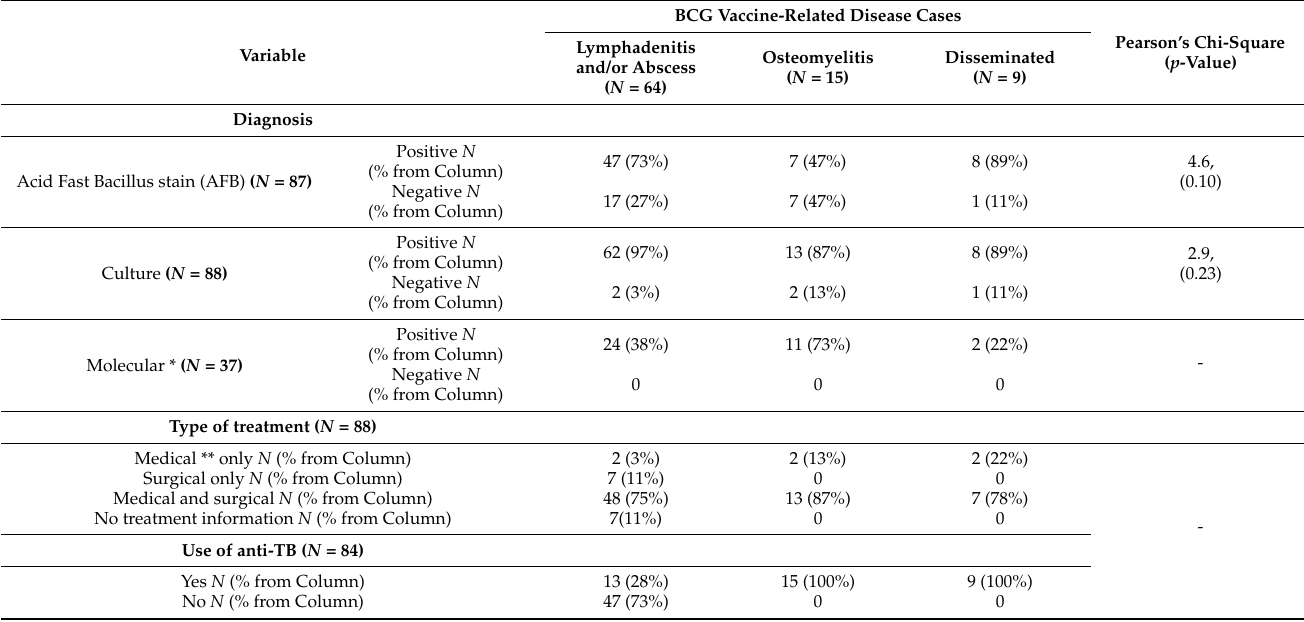
Table 2. Diagnosis, treatment, and outcomes for each type of BCG vaccine-related disease.